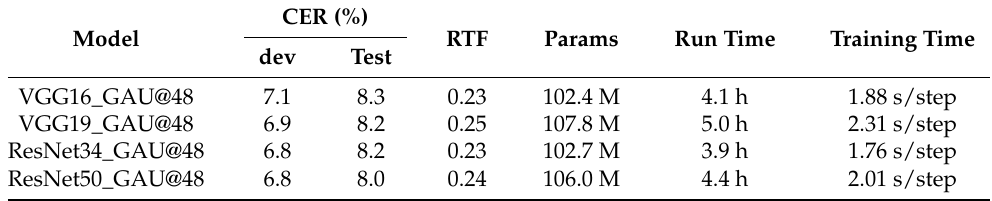
Table 5. Evaluation metrics of different convolutional architectures in the ATC corpus. CER (%) Model RTF